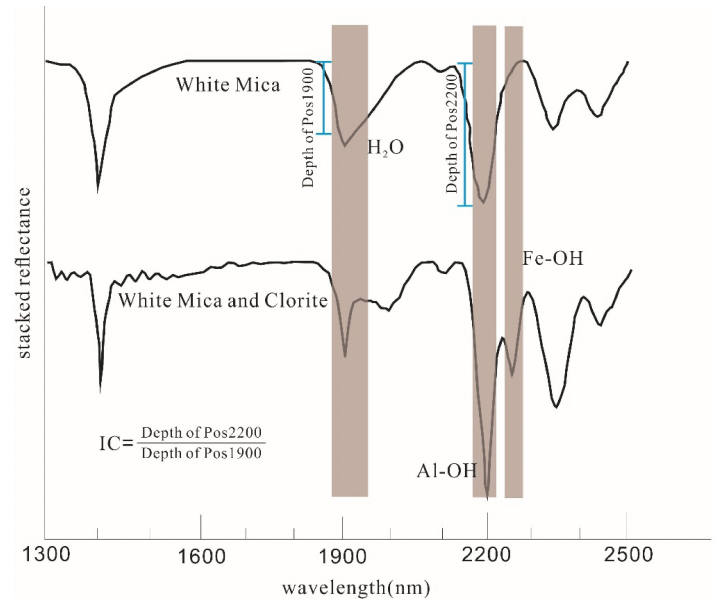
Figure 1. Typical SWIR absorption spectra (Hull quotient corrected) of white mica and a mixture of white mica and chlorite (modified from [1]), showing the absorption band position and depth of Al-OH, Mg-OH, and H 2 O (hydroscopic water).